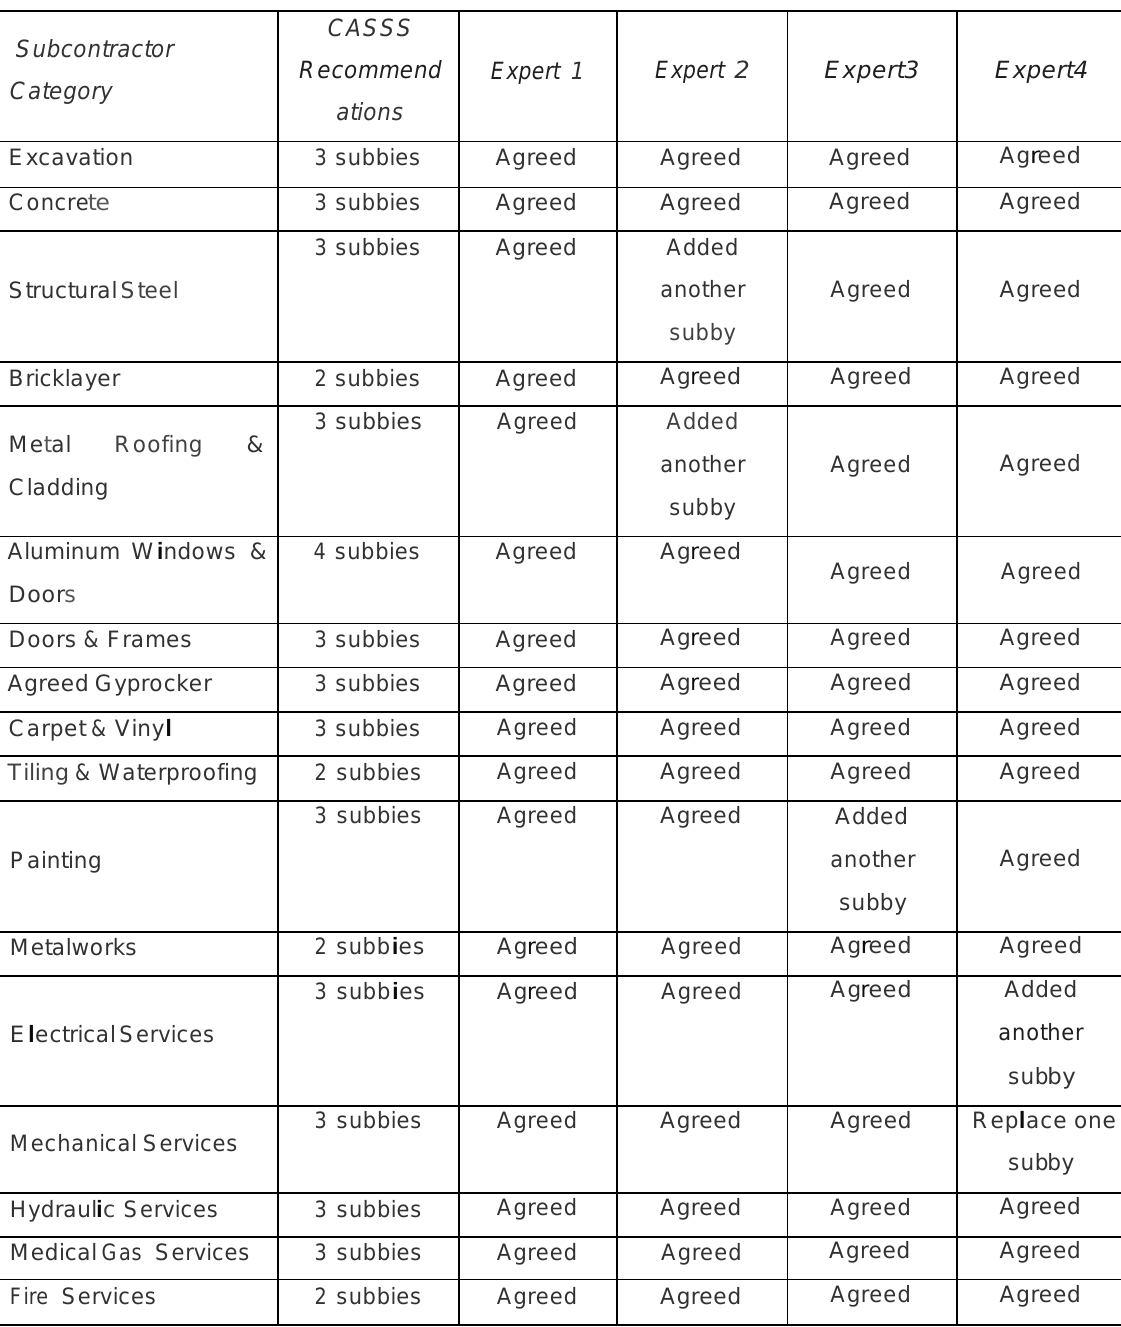
Table 4: Results of system reliability